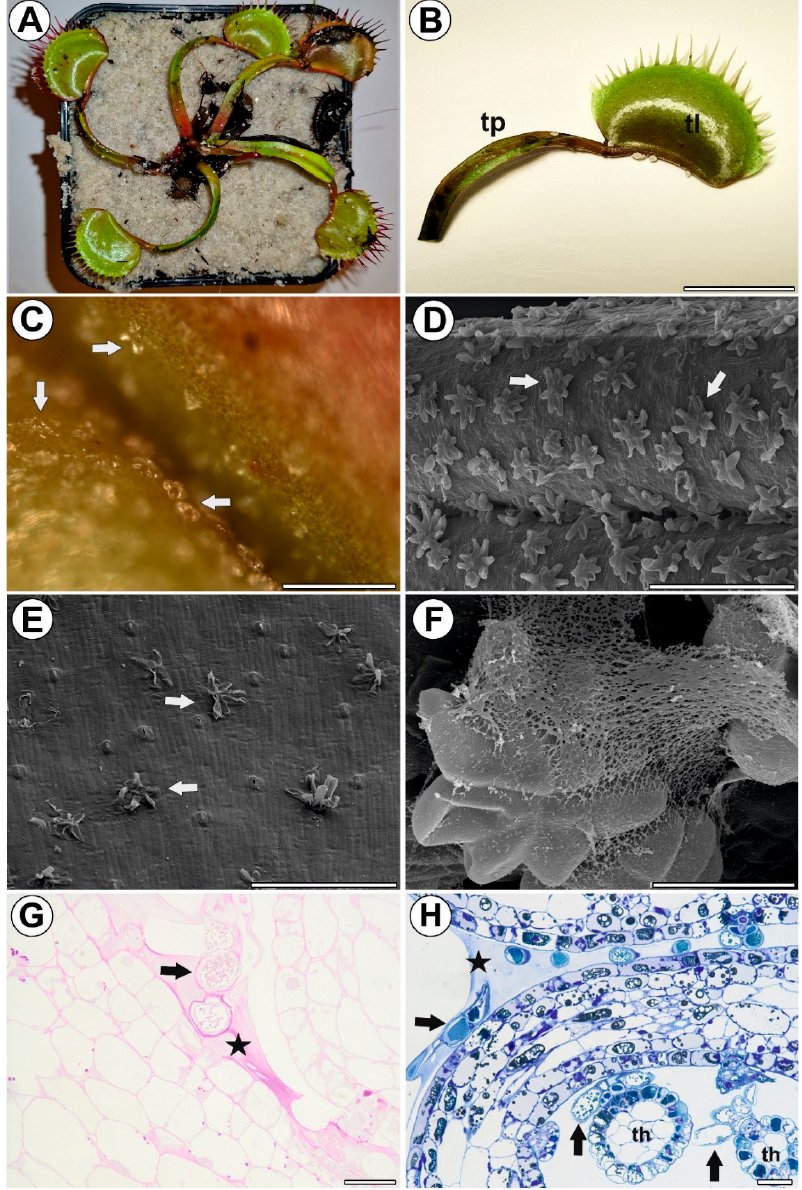
Figure 1. Distribution and morphology of the stellate trichomes of the Dionaea muscipula traps ( A ) D. muscipula plant. ( B ) Leaf morphology; trap petiole (tp), trap lobe (tl), bar 1 cm. ( C ) Stellate trichomes (arrow) on a young, non-opened trap surface, bar 250 µm. ( D ) Stellate trichomes (arrow) on a young, non-opened trap surface, bar 300 µm (scanning electron microscopy—SEM). ( E ) Stellate trichomes (arrow) on the external surface of a mature trap; note that that stellate trichomes have collapsed outer head cells, bar 300 µm (SEM). ( F ) Secretion on the surface of a stellate trichome from a young trap, bar 30 µm (SEM). ( G ) Positive result of the PAS reaction of the secretion between the trap lobes (star), stellate trichome (arrow), and bar 20 µm (light microscopy). ( H ) Section of a young, non-opened trap; note the secretion between the trap lobes (star) and stellate trichomes (arrow) on the marginal teeth (th), bar 25 µm.